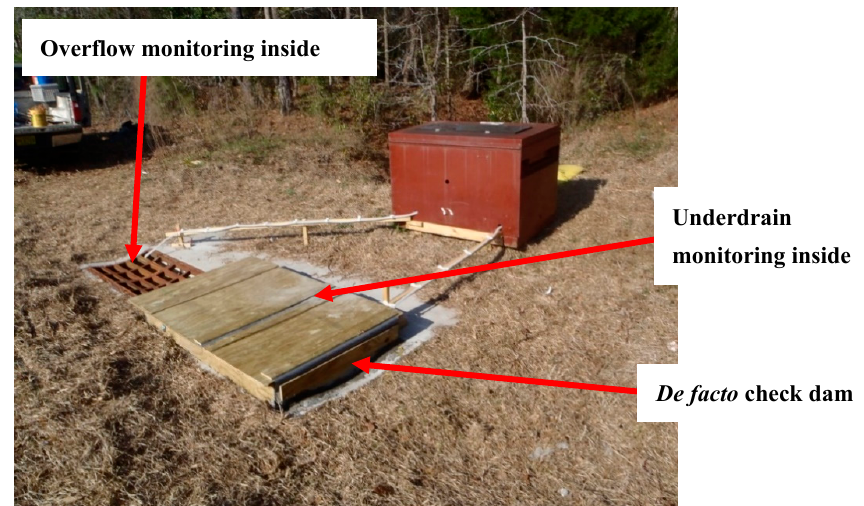
Figure 4. Outlet structure with closed portion for underdrain flow